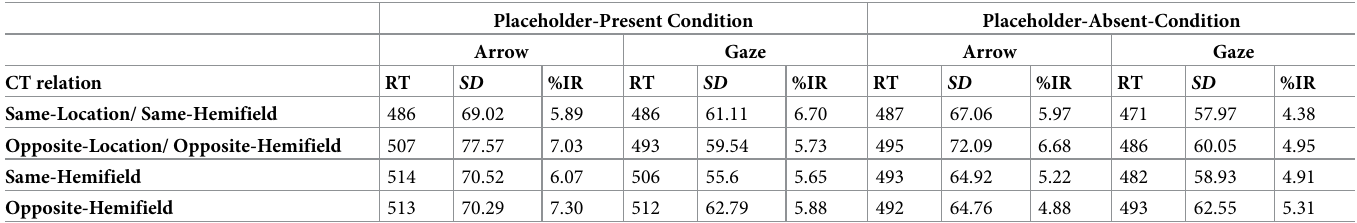
Table 1. Mean reaction times (RT), standard deviation (SD), and percentage of incorrect responses (%IR) as a function of the placeholder-condition, type of cue, and cue-target (CT) relation in Experiment